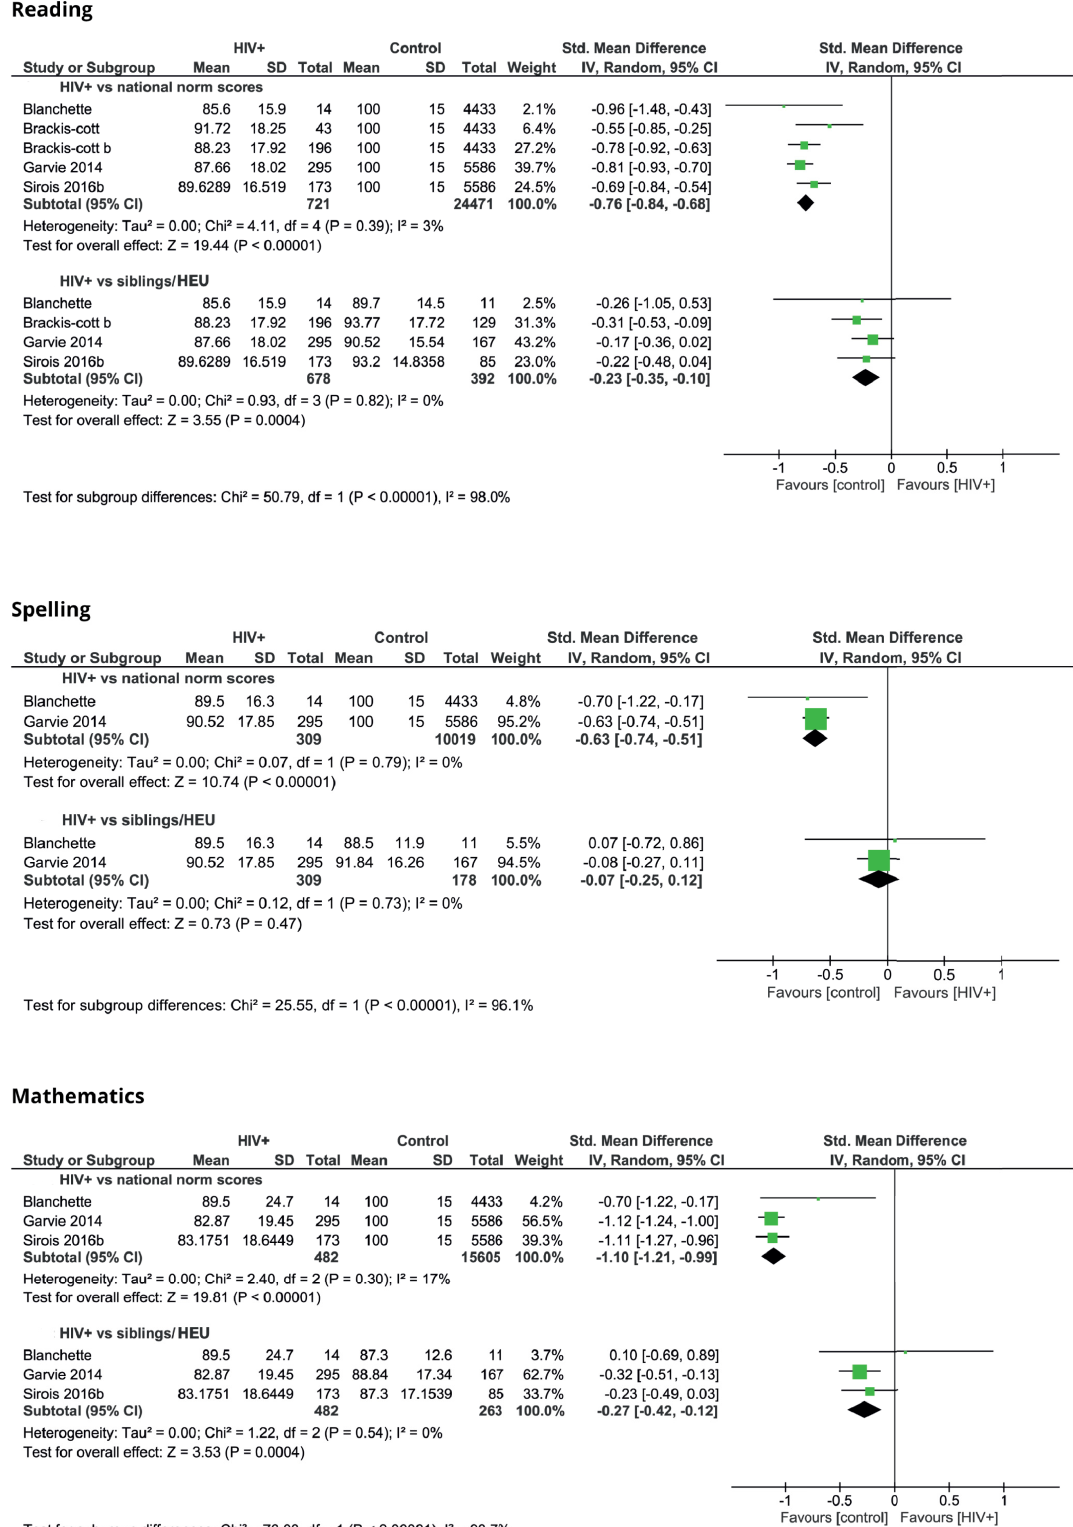
PLOS ONE | https://doi.org/10.1371/journal.pone.0252746 June 4,